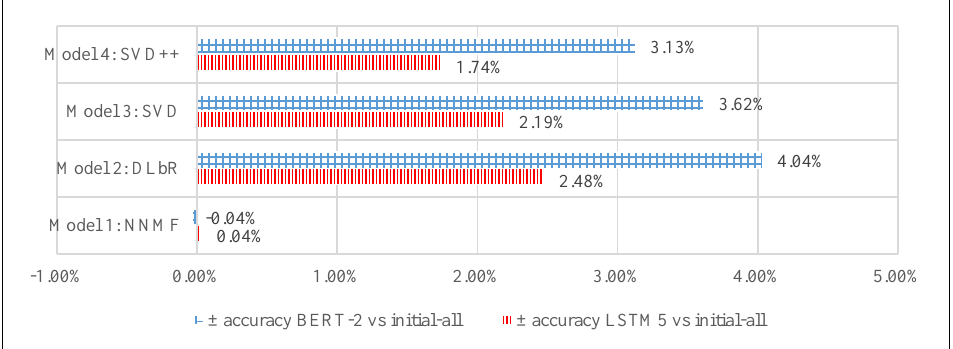
Figure 11. Comparison of the variations produced when using LSTM-5 or BERT-2 against the dataset 𝐷𝐴𝑇𝐴 𝑖𝑛𝑖𝑡.−𝑎𝑙𝑙 , of the four models in accuracy indicator.